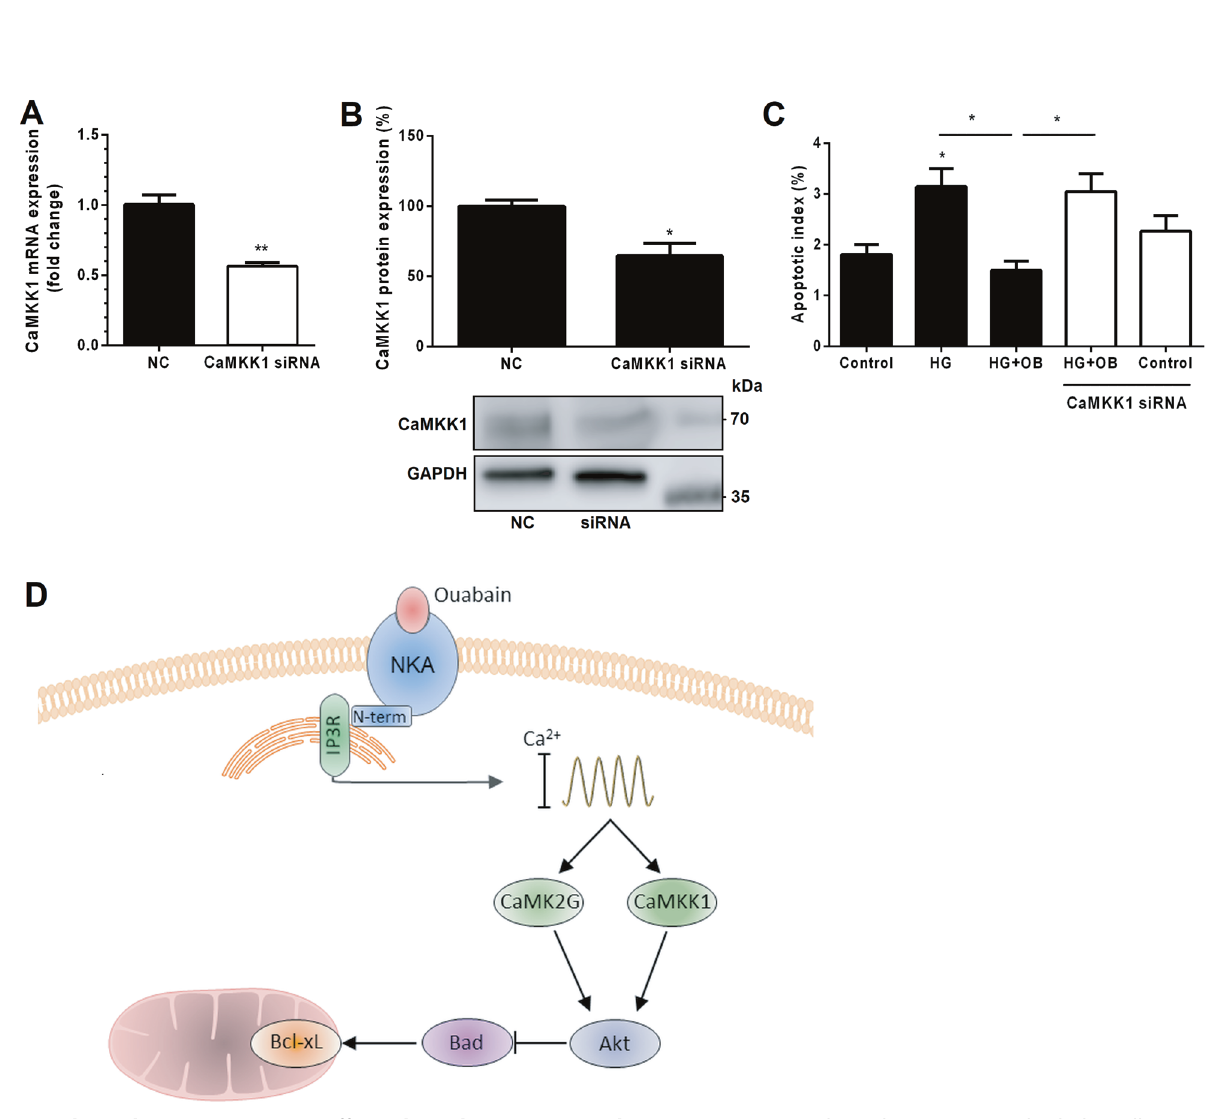
Fig. 7 Ouabain elicits anti-apoptotic effects through CaMKK1 signaling. A CaMKK1 was silenced in rat proximal tubular cells (PTCs). RT- qPCR shows that mRNA expression of CaMKK1 is reduced by about 40% after siRNA treatment. N = 3. B Western blot of transfected cells showing downregulation of CaMKK1 by 35%. N = 3. C TUNEL assay of PTCs challenged with high glucose (HG) with or without ouabain and CaMKK1-targeting siRNA. Ouabain abolishes HG-induced apoptosis in control cells but not in those transfected with CaMKK1-targeting siRNA. N = 3. * p < 0.05 and ** p < 0.01 vs. controls. D Schematic presentation of the proposed signaling cascade by which ouabain protects against apoptosis. Binding of ouabain to Na + ,K + -ATPase results in concerted activation of the inositol 1,4,5-trisphosphate receptor (IP3R) and store- operated calcium channels regulated by STIM [34]. Calcium oscillations are subsequently generated by the endoplasmic reticulum. This activates CaM/Ca 2 + , which in turn binds to and activates CaMKK1 and/or CaMK2G. CaMKK1 and CaMK2G activate Akt via phosphorylation (T308 [23] and S473 [32], respectively). Akt phosphorylates Bad at S136, resulting in sequestration of Bad by 14-3-3 protein and inactivation of its pro-apoptotic